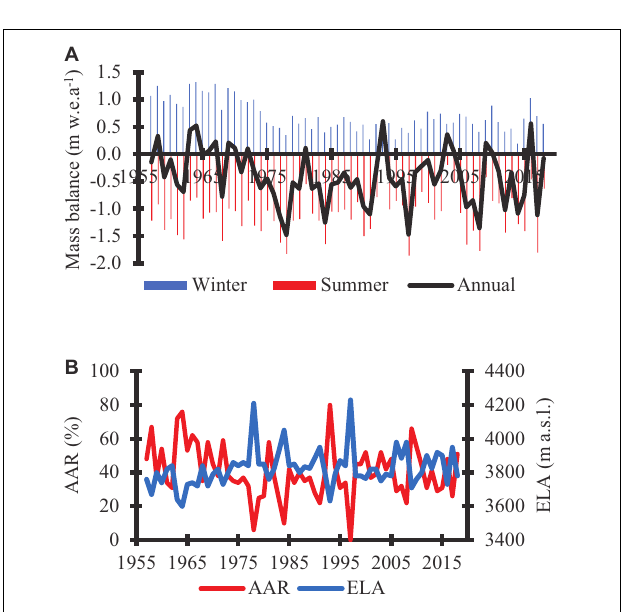
FIGURE 10 | Time series of the (A) components of glaciological mass balance and (B) equilibrium line altitude and accumulation–area ratio for the Central Tuyuksu